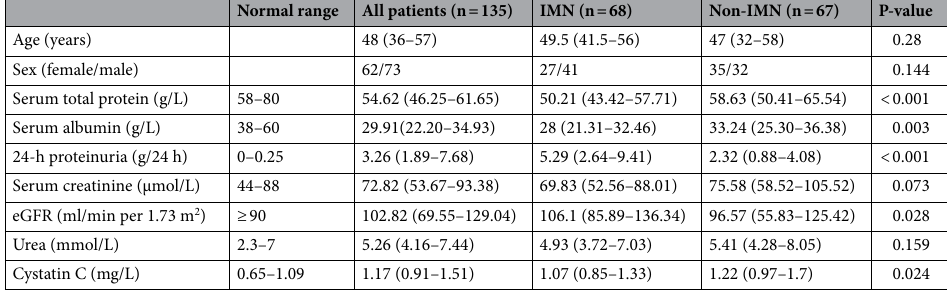
Table 1. Clinical characteristics of patients. Continuous variables are presented as median (interquartile ranges). IMN idiopathic membranous nephropathy, eGFR estimated glomerular filtration